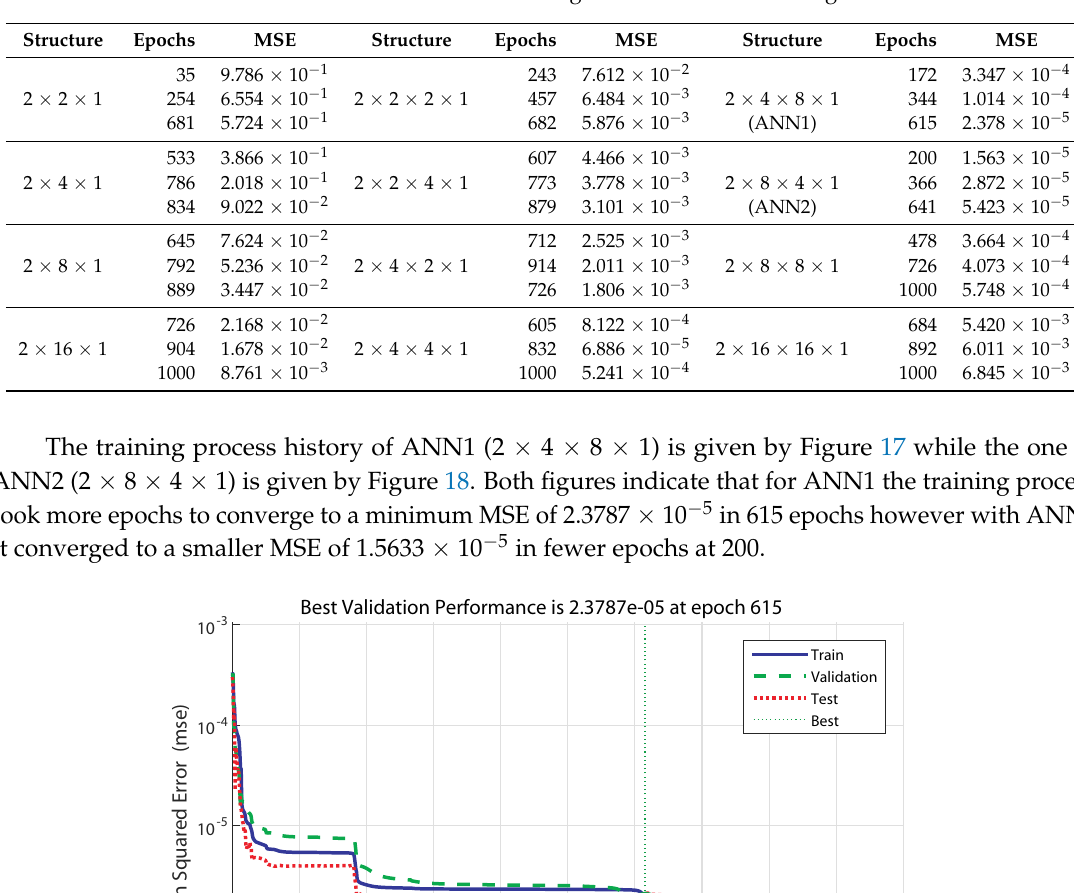
Table 3. Validation solutions of training different structures using LMA.